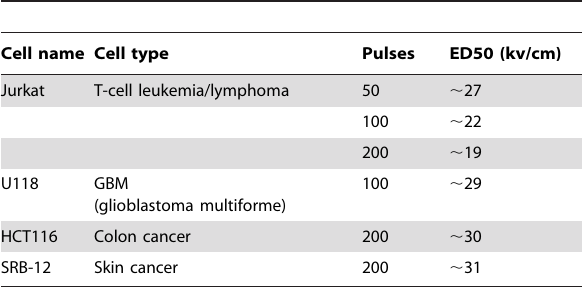
Table 1. Required pulse number at 50, 100, or 200 pulses to kill 50% cells (ED50) of various cancer